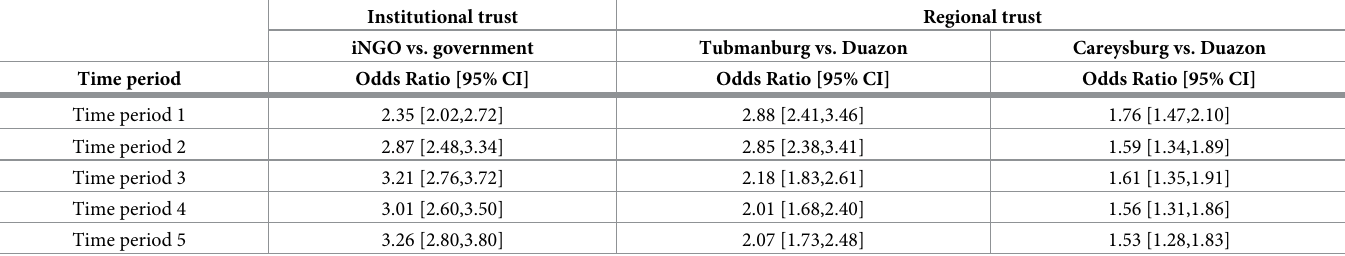
Table 3. Odds ratios and 95% confidence intervals for trust of iNGOs vs. government and trust in Tubmanburg (urban, high incidence) and Careysburg (rural, low exposure) vs. in Duazon (peri-urban, high exposure) at each of five time periods. Odds ratios were calculated from an ordinal logistic regression model. In the first entry, the odds of reporting trust of iNGOs as higher than trust of the government in the first time period were 2.35, holding all other variables